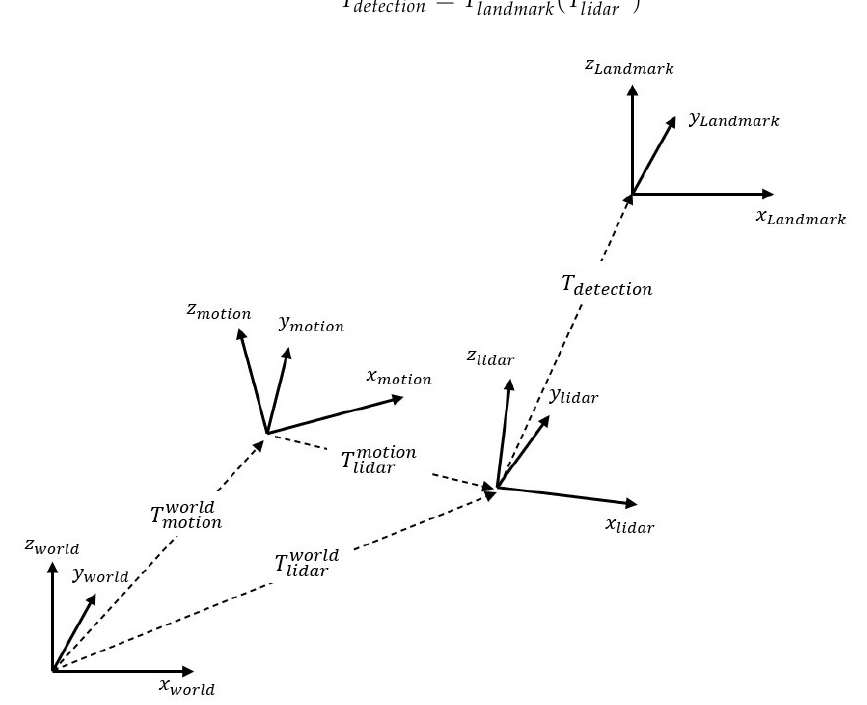
Figure 5. Relationship between the coordinate systems: world, motion, LiDAR, landmark